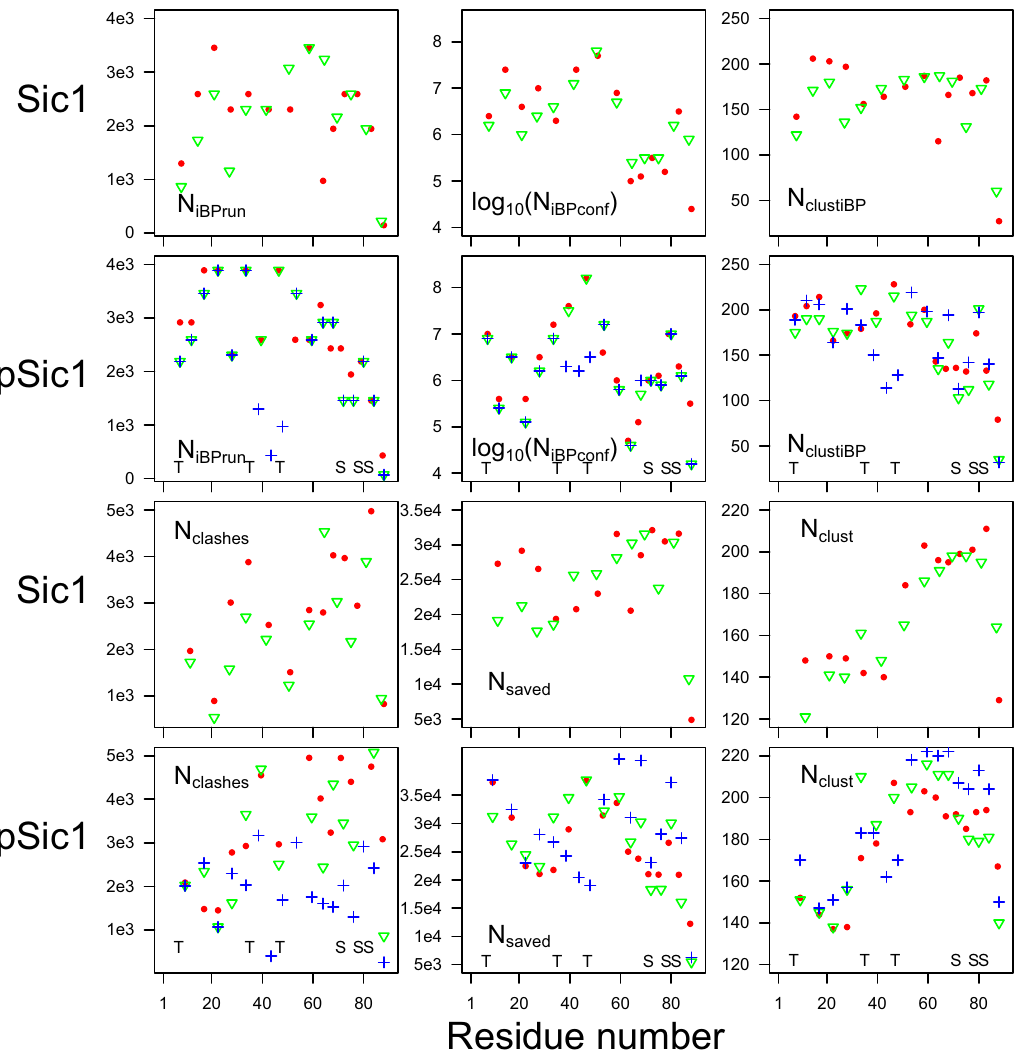
Figure 1. Parameters of the iBP and assembly steps of the TAiBP procedure. The signs red and green correspond respectively to the duplicated runs in which thresholds of 0.01 and 0.011 have been applied on the probability Ramachandran map. The blue crosses correspond to the run pSic1 conformations. The positions of phosphorylated Threonines and Serines are marked with T and S for the runs on pSic1. The parameters are plotted along the number of the residue located at the middle of the fragment (iBP step) or at the middle of the last attached fragment (assembly